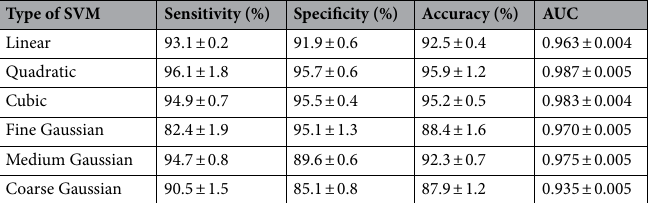
Table 3. Comparison of the classification performance of SVM classifiers for the dataset of the large SDD probe (n = 1526) containing reflectance values from 350 to 1919 nm.